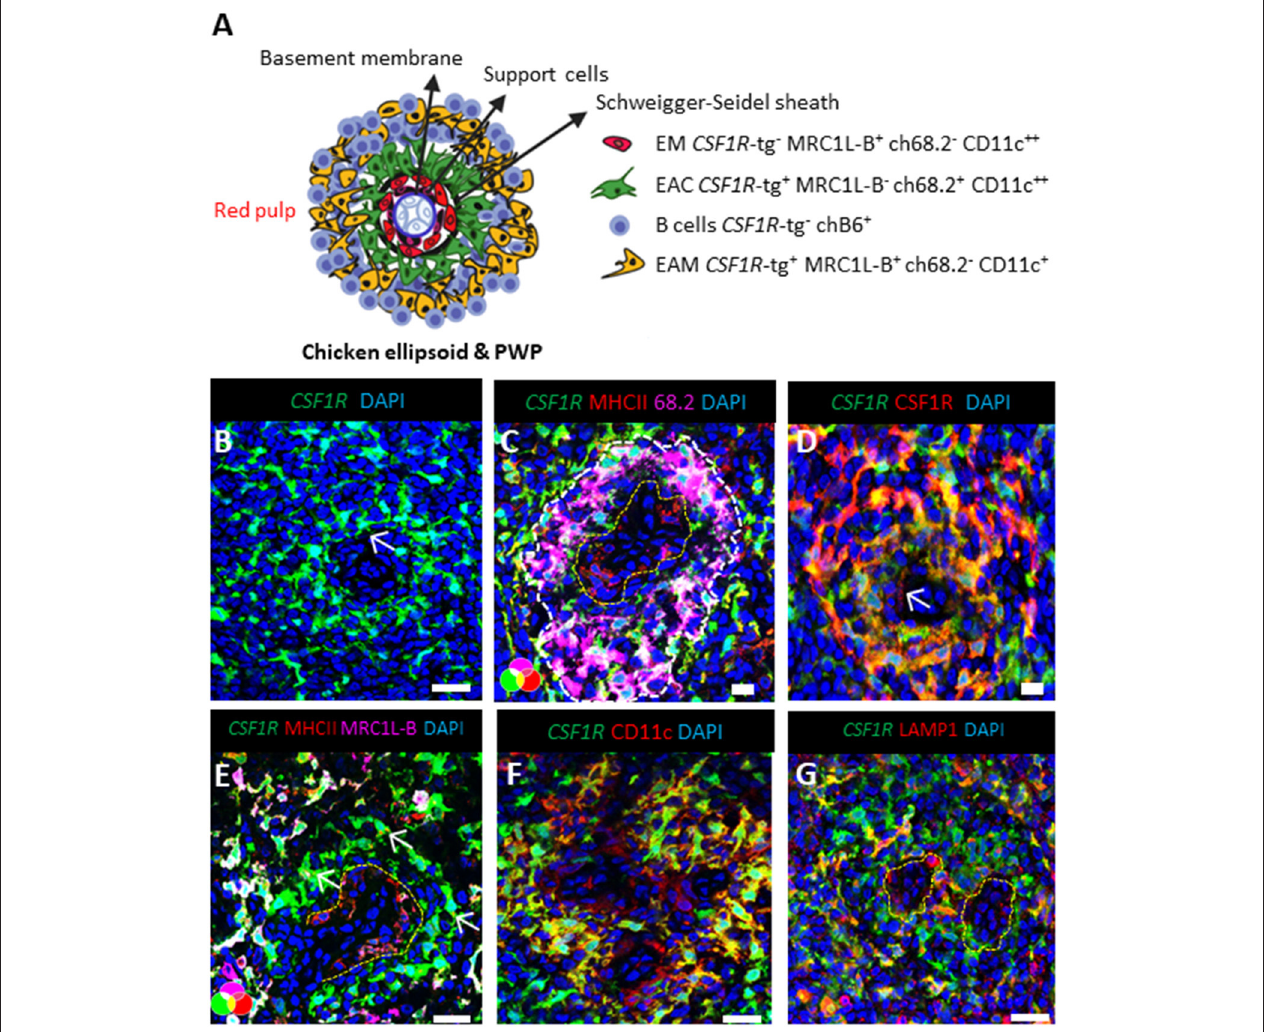
FIGURE 2 | The ellipsoid contains CSF1R -tg negative cells that co-express chicken macrophage related markers. (A) Schematic overview of the chicken PWP, ellipsoid and associated cells, EC; ellipsoid macrophages, EAC; ellipsoid-associated cells, EAM: ellipsoid-associated macrophages; (B) confocal analysis of the PWP demonstrates the dendrites of the CSF1R -tg + EAC cells protruding into the ellipsoid (white arrow); (C) MHCII and Ch68.2 staining demonstrates the presence of CSF1R -tg neg MHCII + Ch68.2 neg cell population named ellipsoid macrophages (EM) that are located within the ellipsoid; (D) CSF1R is expressed by the CSF1R -tg neg EM; (E) in contrast to EM and EAM, EAC lack MRC1L-B expression; (F) EAC and EM express high levels of CD11c in contrast to the EAM; (G) LAMP1 is expressed by all CSF1R -tg + and CSF1R -tg neg cells in the PWP. Yellow lines outline the location of the EM. Data is representative of five CSF1R -eGFP transgenic chickens at 5–6 weeks of age. Scale bars for images (B,E–G) are 100 µ m and images (C,D) are 50 µ